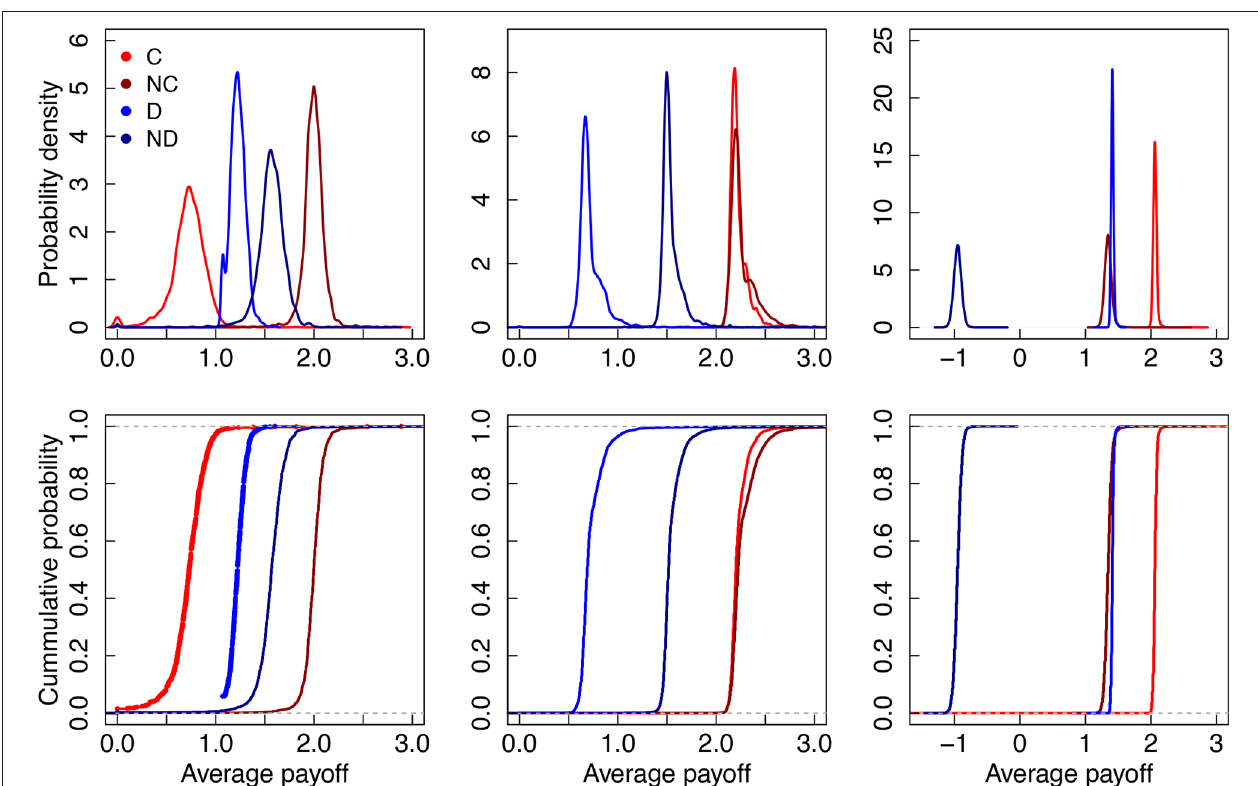
FIGURE 6 | Exit option changes the evolutionary trend. From top to bottom, we present the probability density and the cumulative probability of the average payoff, respectively. We also use red (wine) to denote boundary cooperators (C) [neighbors of a boundary cooperator (NC)] and blue (dark blue) to represent a defector (D) [neighbors of a boundary defector (ND)]. From left to right, the exit cost γ equal to 0, 3, 10,